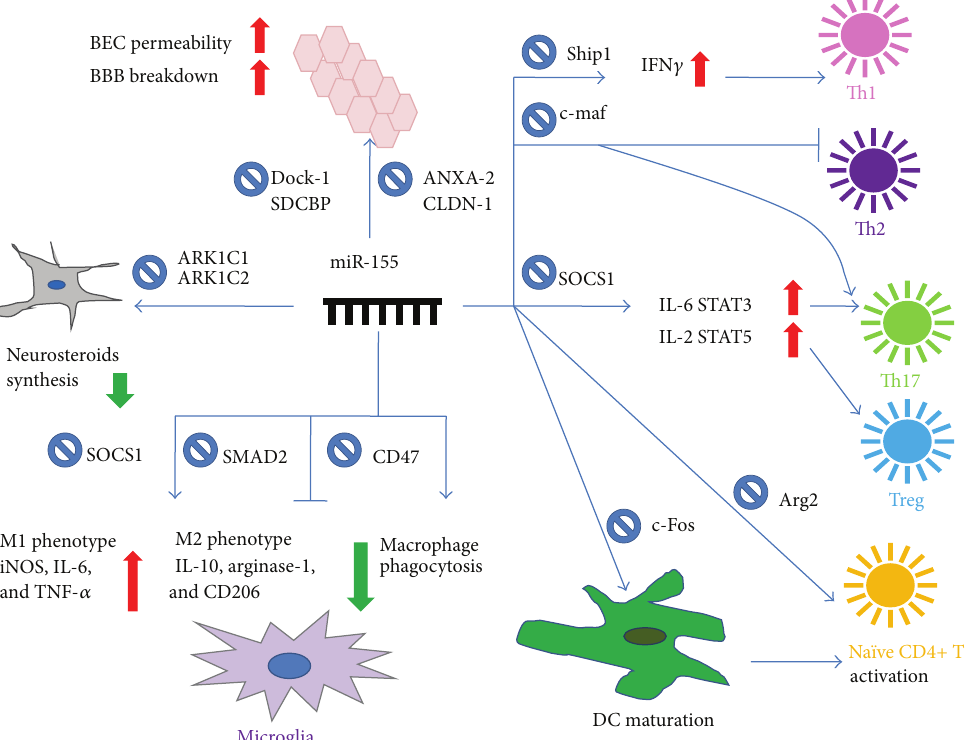
Figure 1: Summary of putative mechanisms through which miR-155 could modulate MS. miR-155 could regulate several inflammatory and anti-inflammatory cytokines through different target genes, participating in MS pathological processes such as periphery inflammation, BBB dysfunction, and CNS